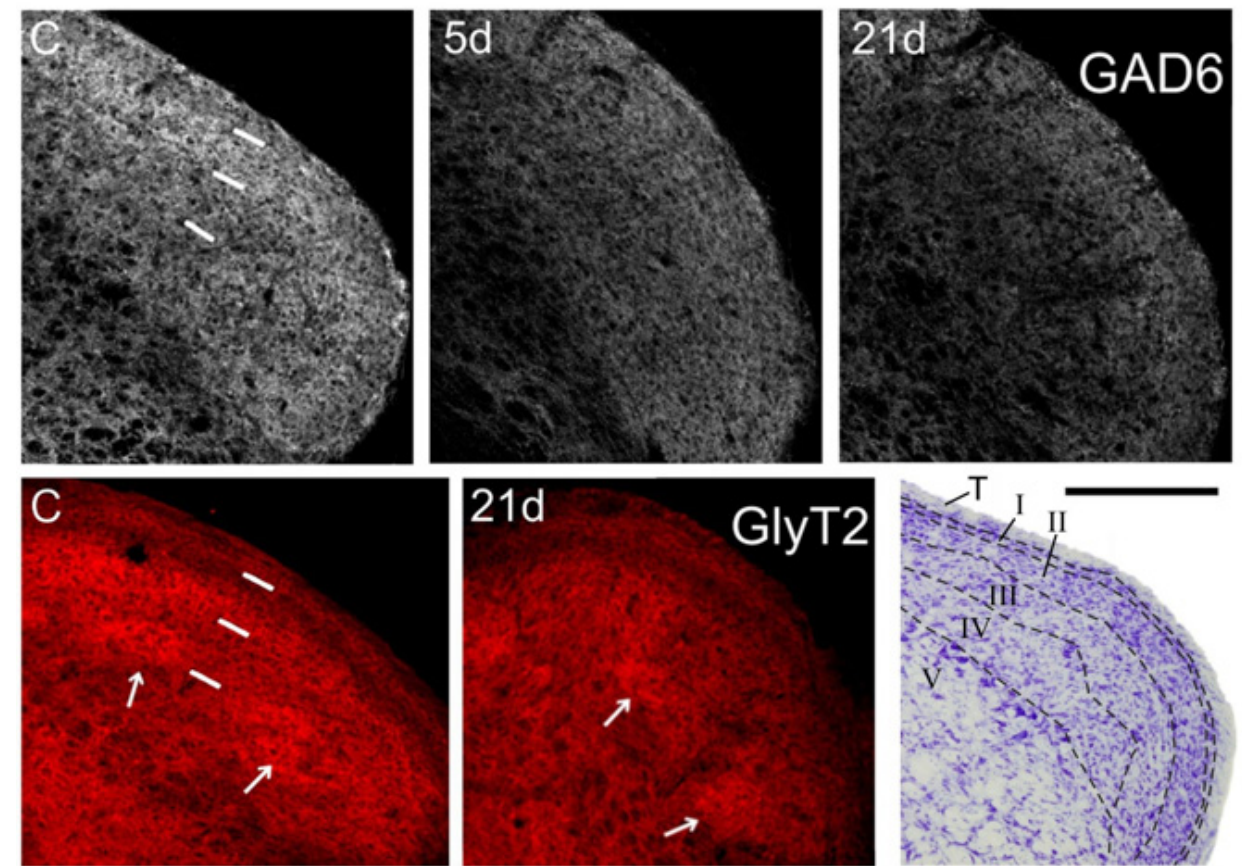
Figure 2. Coronal sections through the right Sp5C caudal to the obex showing immunofluorescence for GAD-6 ( gray, top panels ), and GlyT2 ( red, bottom panels ). GAD-6 expression fades in all laminae at 5 days post-operation ( dpo; 5d ), and decreases even further at 21 dpo, when the loss is more marked in the ventral 1/2 of the nucleus. Less obvious, but still noticeable is a heterogeneous decrease in GlyT2 expression, which affects mostly lamina II and, irregularly, lamina III in the ventral 1/2 of the nucleus (where afferents from the IoN dominate). Arrows point to some ‘patches’ with strong expression of GlyT2 in laminae III-IV, which persist after CCI-IoN. In control sections ( C ) short, white bars indicate the approximate boundaries between the trigeminal tract, laminae I-II, lamina III and lamina IV. These sections were among those used for densitometric measures. A Nissl-stained section ( lower right corner ) shows approximately the same level of Sp5C, with interlaminar boundaries marked by dashed lines. T, trigeminal tract. Scale bar = 500 µm.